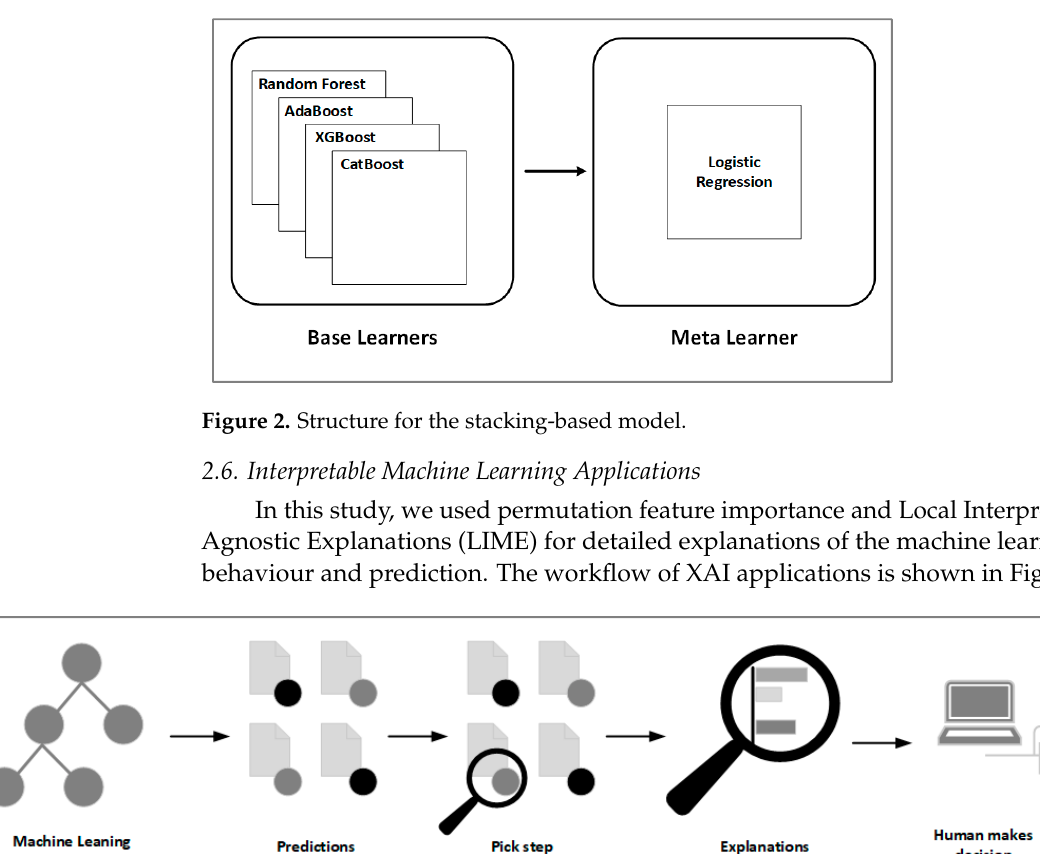
Figure 2. Structure for the stacking-based model.